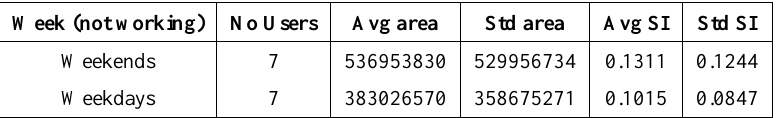
Table 15. Average and standard deviation of area and shape index of not working users grouped based on weekdays.